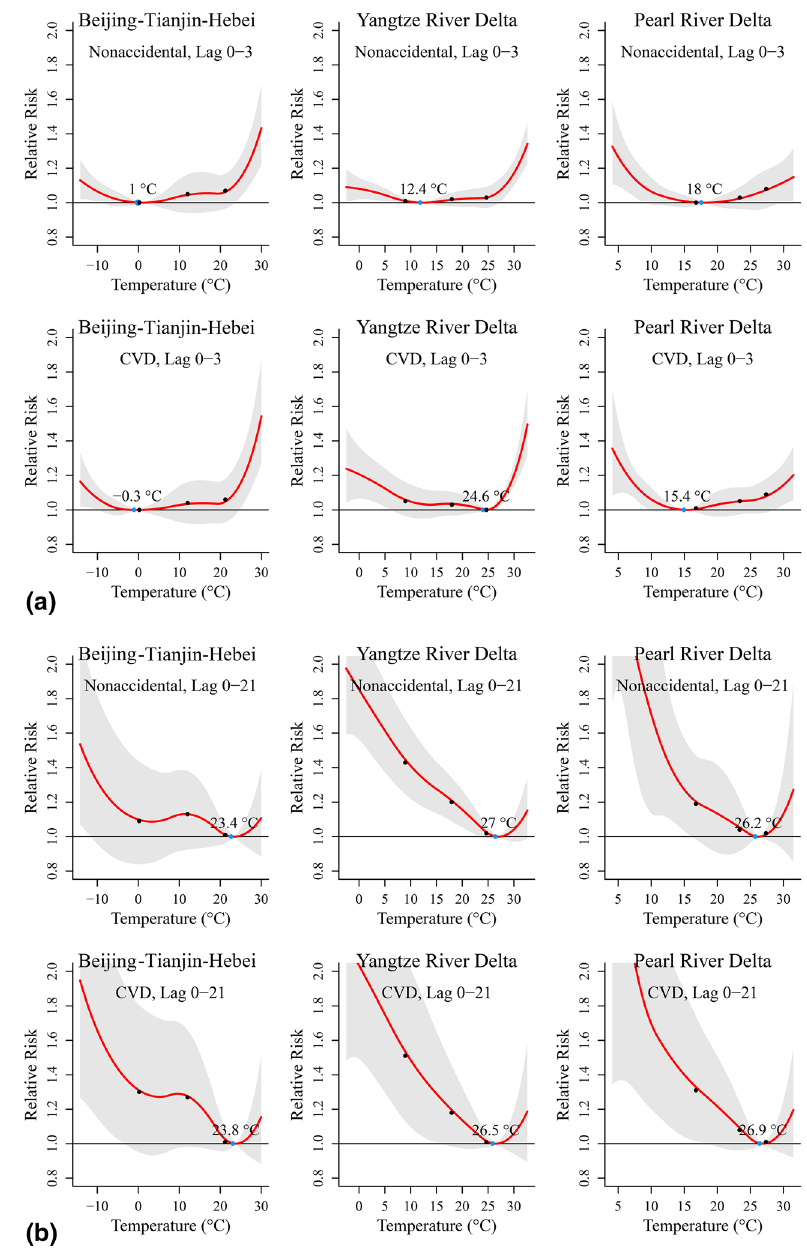
Fig. 4 Pooled effects of temperature on nonaccidental and cardiovascular disease (CVD) mortality with 0–3 and 0–21 lag days in each city cluster, with reference to mortality risk at the minimum- mortality temperature (MMT) of the temperature distribution. The pooled results are shown as smooth red lines, and the gray areas are 95% confidential intervals. The light blue points on the curves are the MMT points (the specific values are shown above the points), and the three black points from left to right on the curves represent the 25th, 50th, and 75th percentile of the temperature distribution,